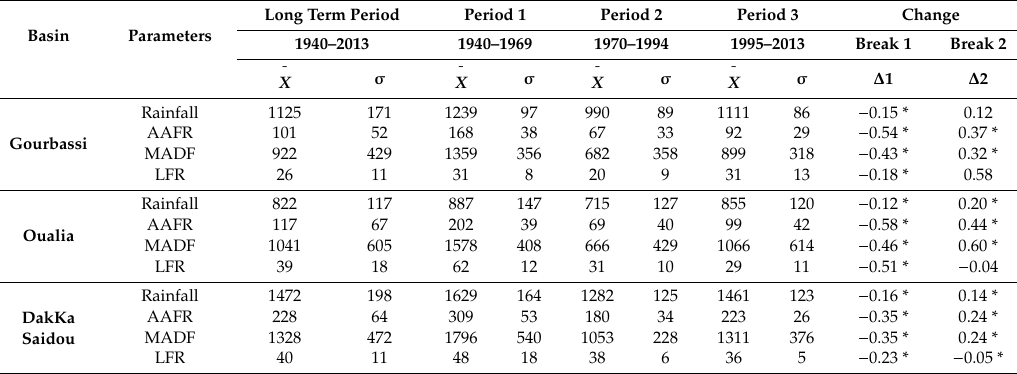
Table 2. Mean, standard deviation and changes in hydroclimatic variables.